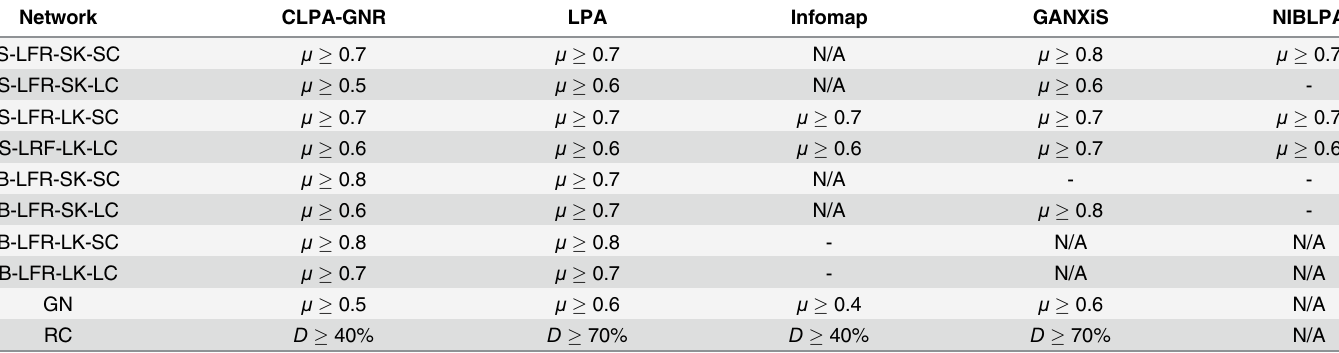
Table 5. The values of μ and D when CLPA-GNR, LPA, Infomap, GANXiS and NIBLPA obtain trivial detection. Network